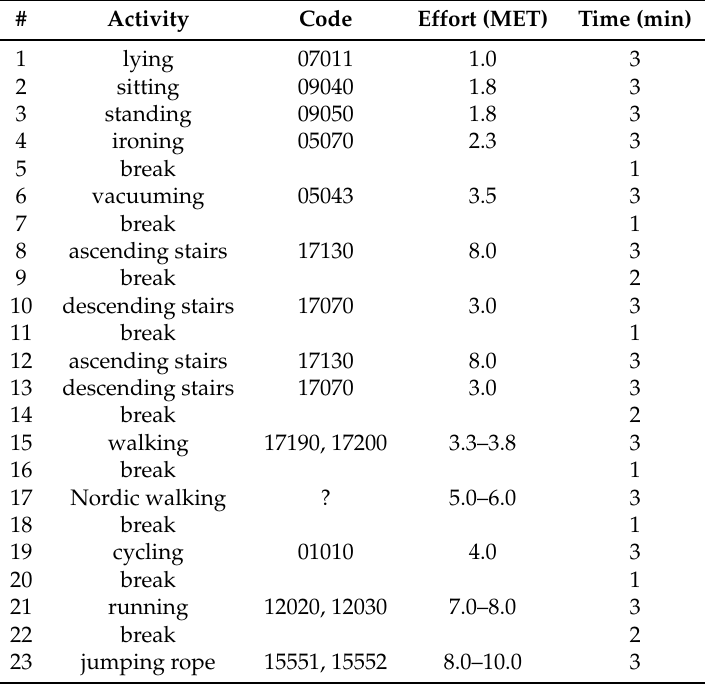
Table 2. Protocol for data collection, including the activity, the estimated effort (through the metabolic equivalent) and the time each activity must be performed. MET, metabolic equivalent.